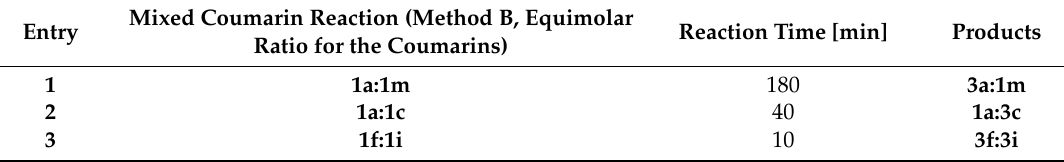
Table 4. Mixed reactions on the coumarin